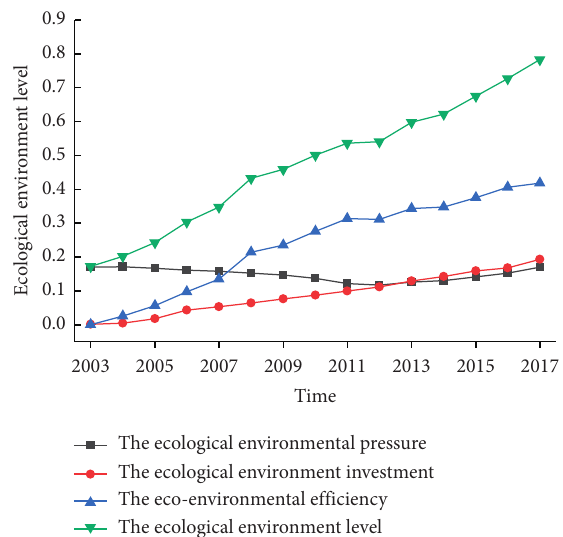
Figure 4: The evolution process of eco-environment level in Liupanshui